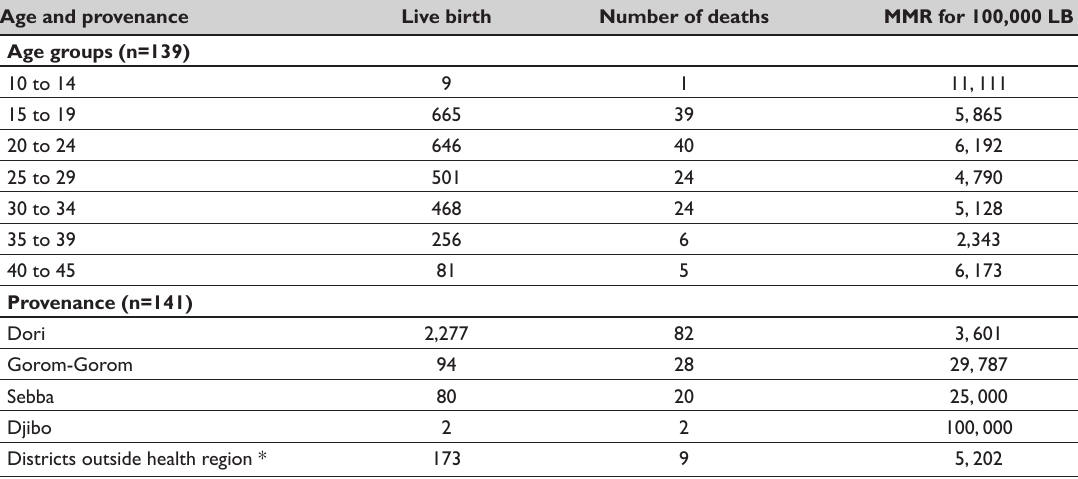
Table 3: Maternal mortality ratio by age and provenance of patients at Dori Hospital, Burkina Faso, 2014-2016